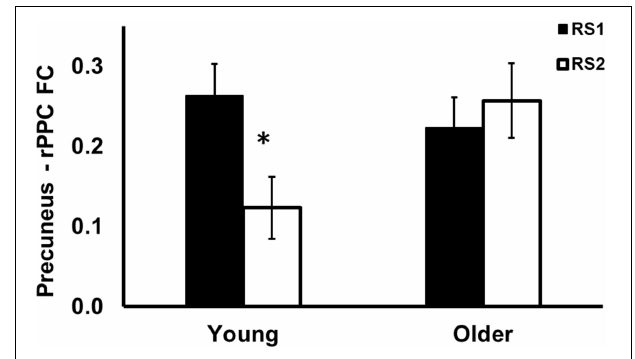
FIGURE 3 | Region of interest analysis of FC between precuneus and right posterior parietal cortex during RS1 and RS2. Significant age × session interaction effect on the FC between precuneus and right posterior parietal cortex. Specifically, the young group showed significant decreased FC between precuneus and right posterior parietal cortex, while no such differences were observed in the older group. *indicates pFDR < 0.05.